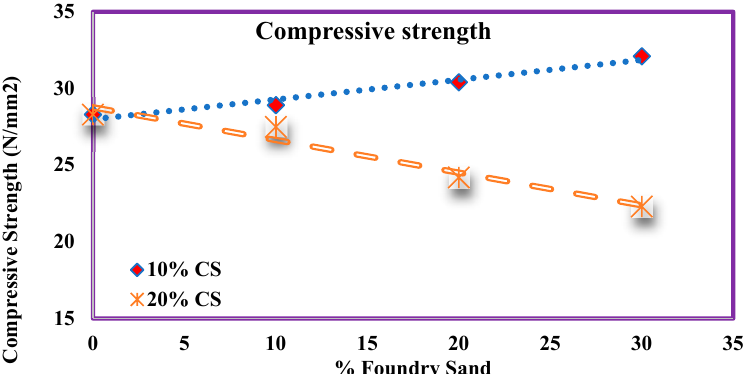
Figure 9. The compressive strength of concrete contains different ratios of FS and CS.